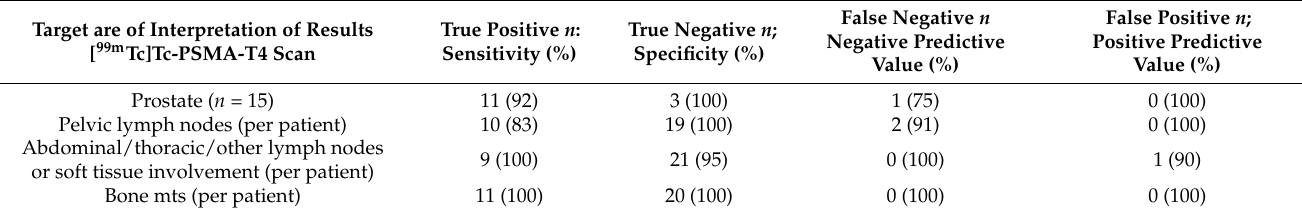
Table A3. Summarized results of [ 99m Tc]Tc-PSMA-T4 examination for the whole group of patients included in the